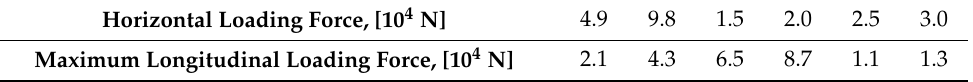
Figure 1. Experimental Process of Friction Clamping Load of Spreader. ( a ) Horizontal load chart, ( b ) Vertical load chart. Table 1. Data of friction clamping of a spreader.